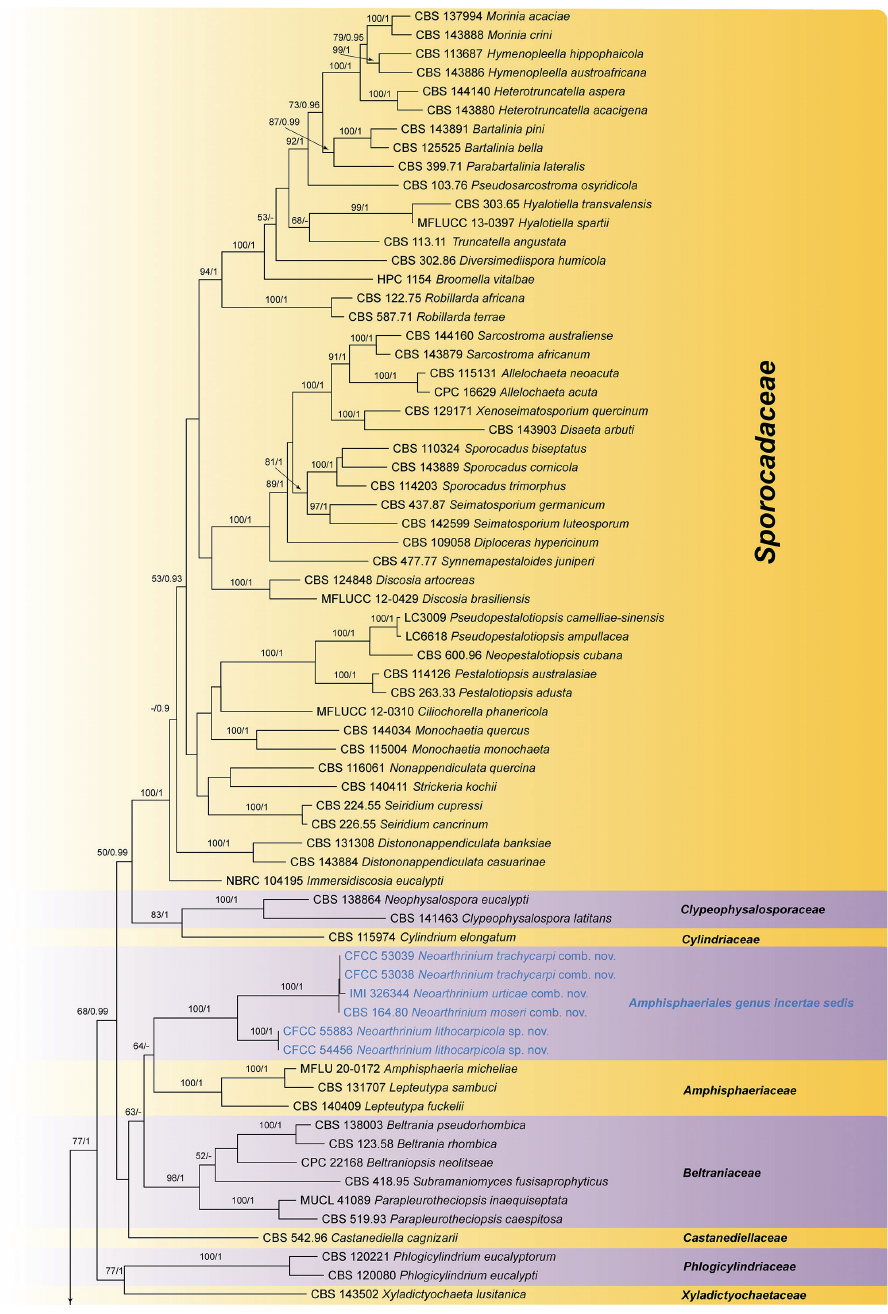
Figure 1. Phylogram of Amphisphaeriales resulting from a Maximum Likelihood analysis, based on a combined matrix of ITS, LSU, tef1 and tub2 . Numbers above the branches indicate ML bootstraps (left, ML BS ≥ 50%) and Bayesian Posterior Probabilities (right, BPP ≥ 0.90). The tree is rooted with Clypeosphaeria mamillana (CBS 140735) and Pseudosporidesmium knawiae (CBS 123529). New species and combinations proposed in the present study are marked in